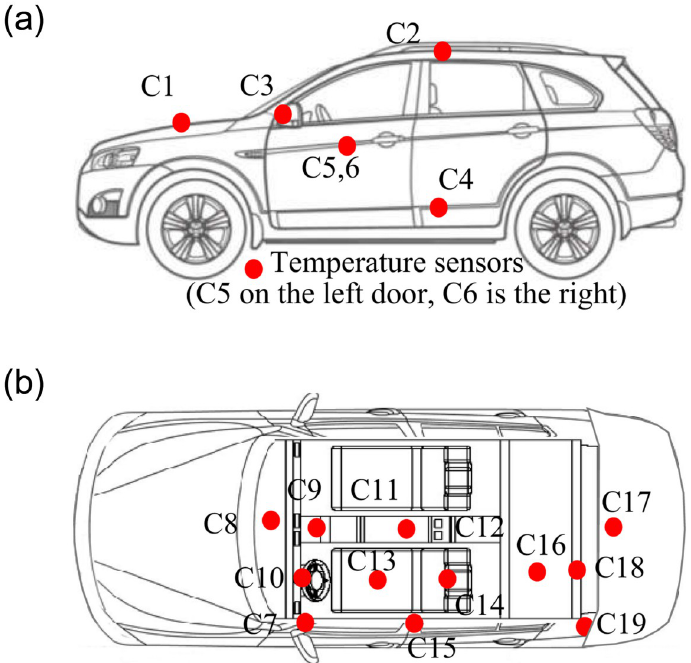
Fig 5. Arrangement of thermocouples in the cabin. The temperature measurement points on the car body were set to analyze the thermal load of the vehicle. (a): Measurement points on the car body. (b): Measurement points in the